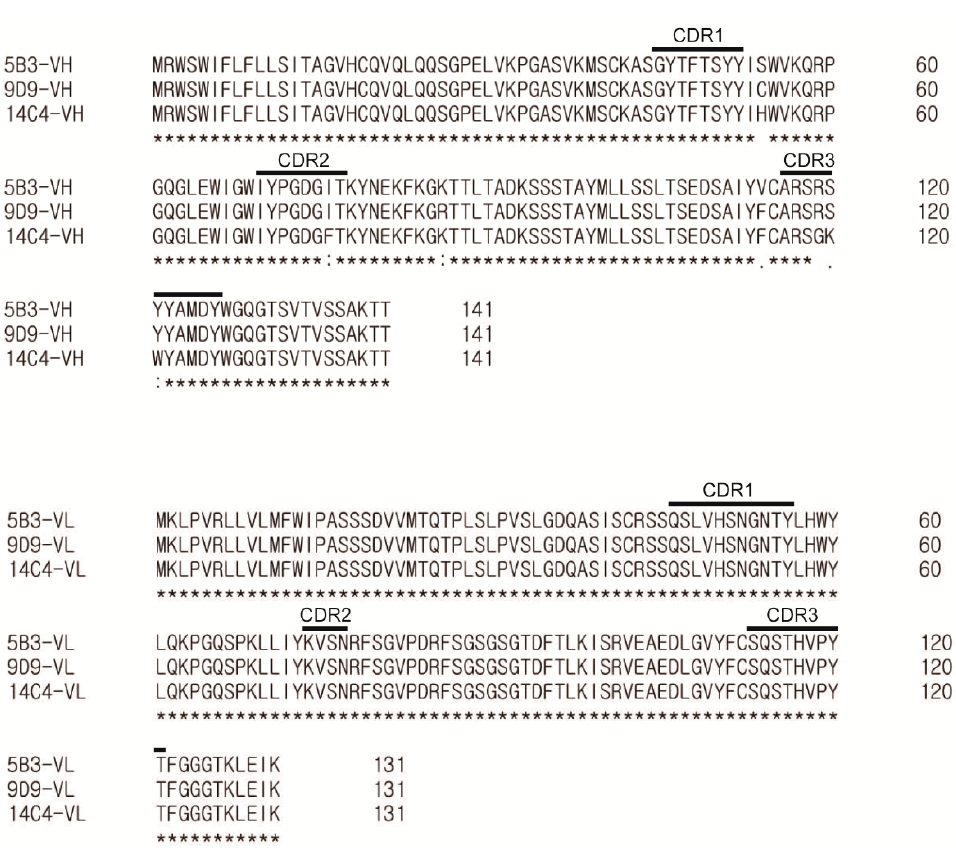
Figure 3. Amino acid sequences of VH and VL of anti-S100A9 monoclonal antibodies. An asterisk indicates positions which have a single, fully conserved residue.